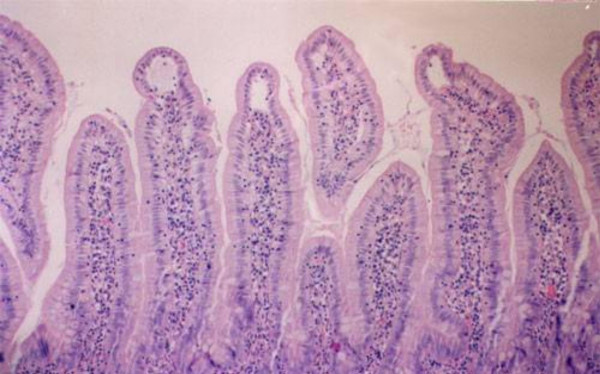
Development of Gruenhagen's space at tip of a villus in group III rats (Grade II) (HE, ×100).